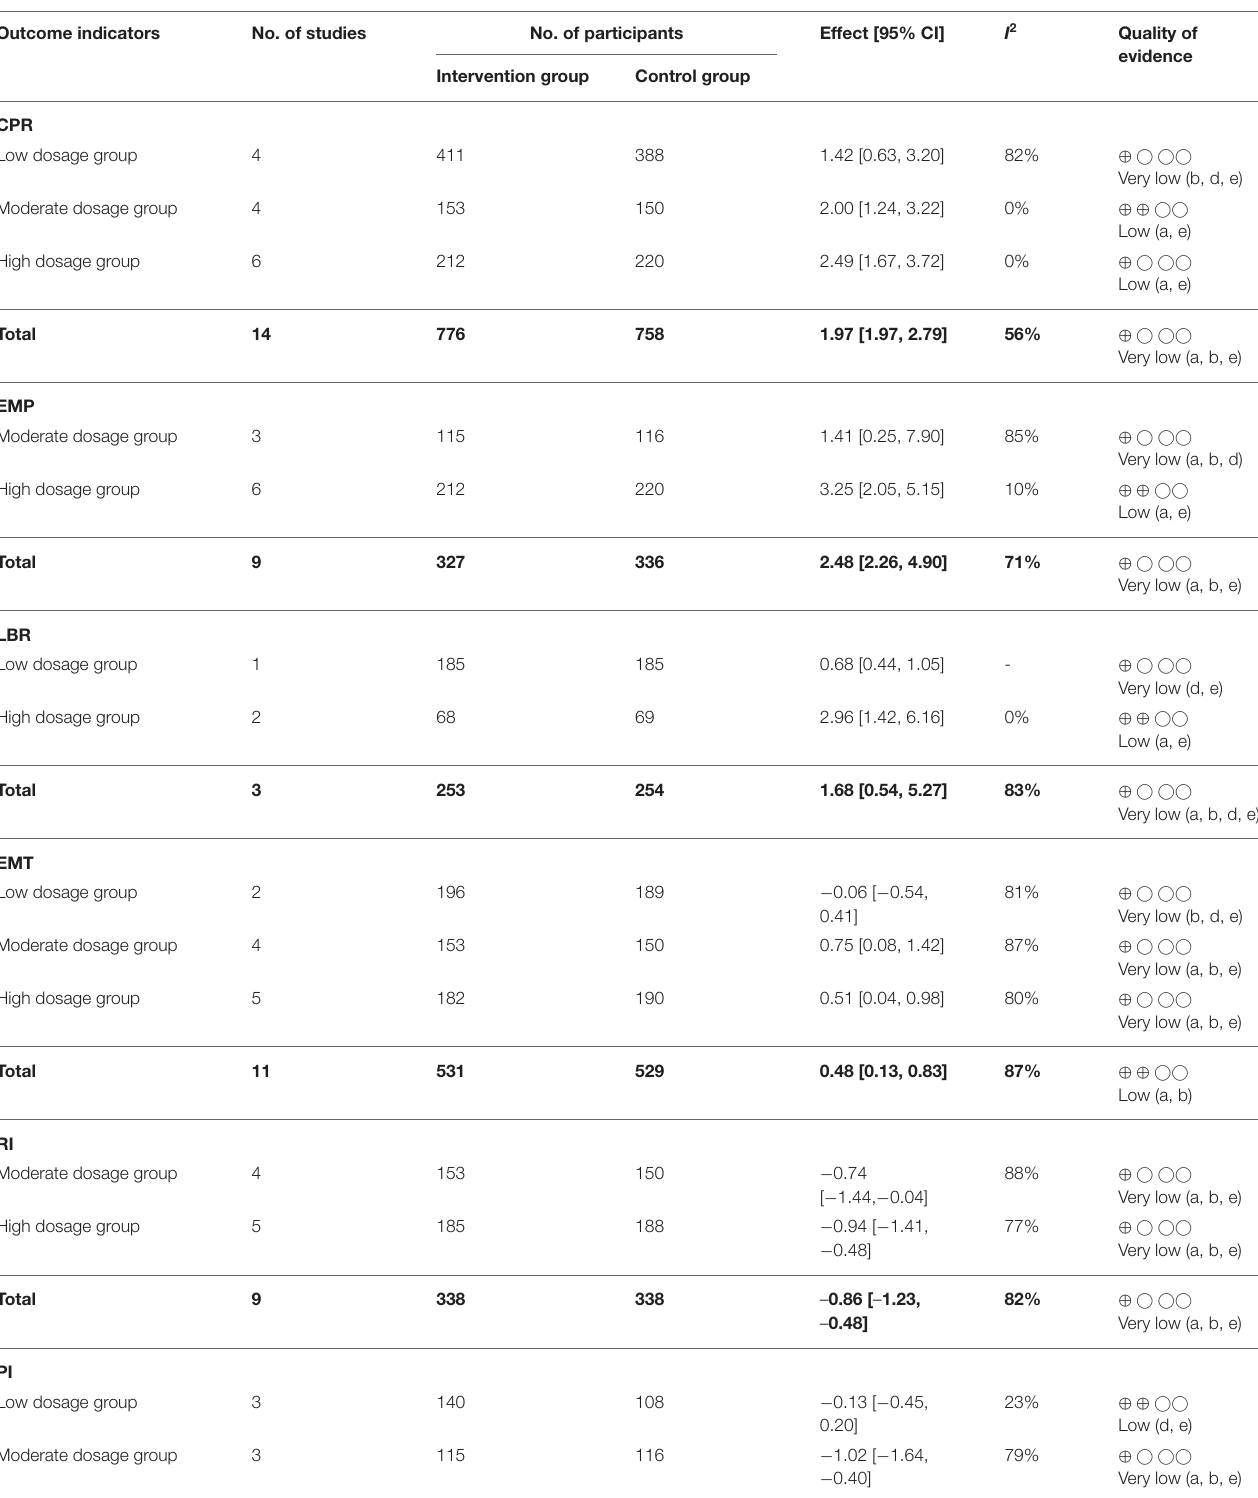
TABLE 3 | Quality of evidence-based on GRADE. Outcome